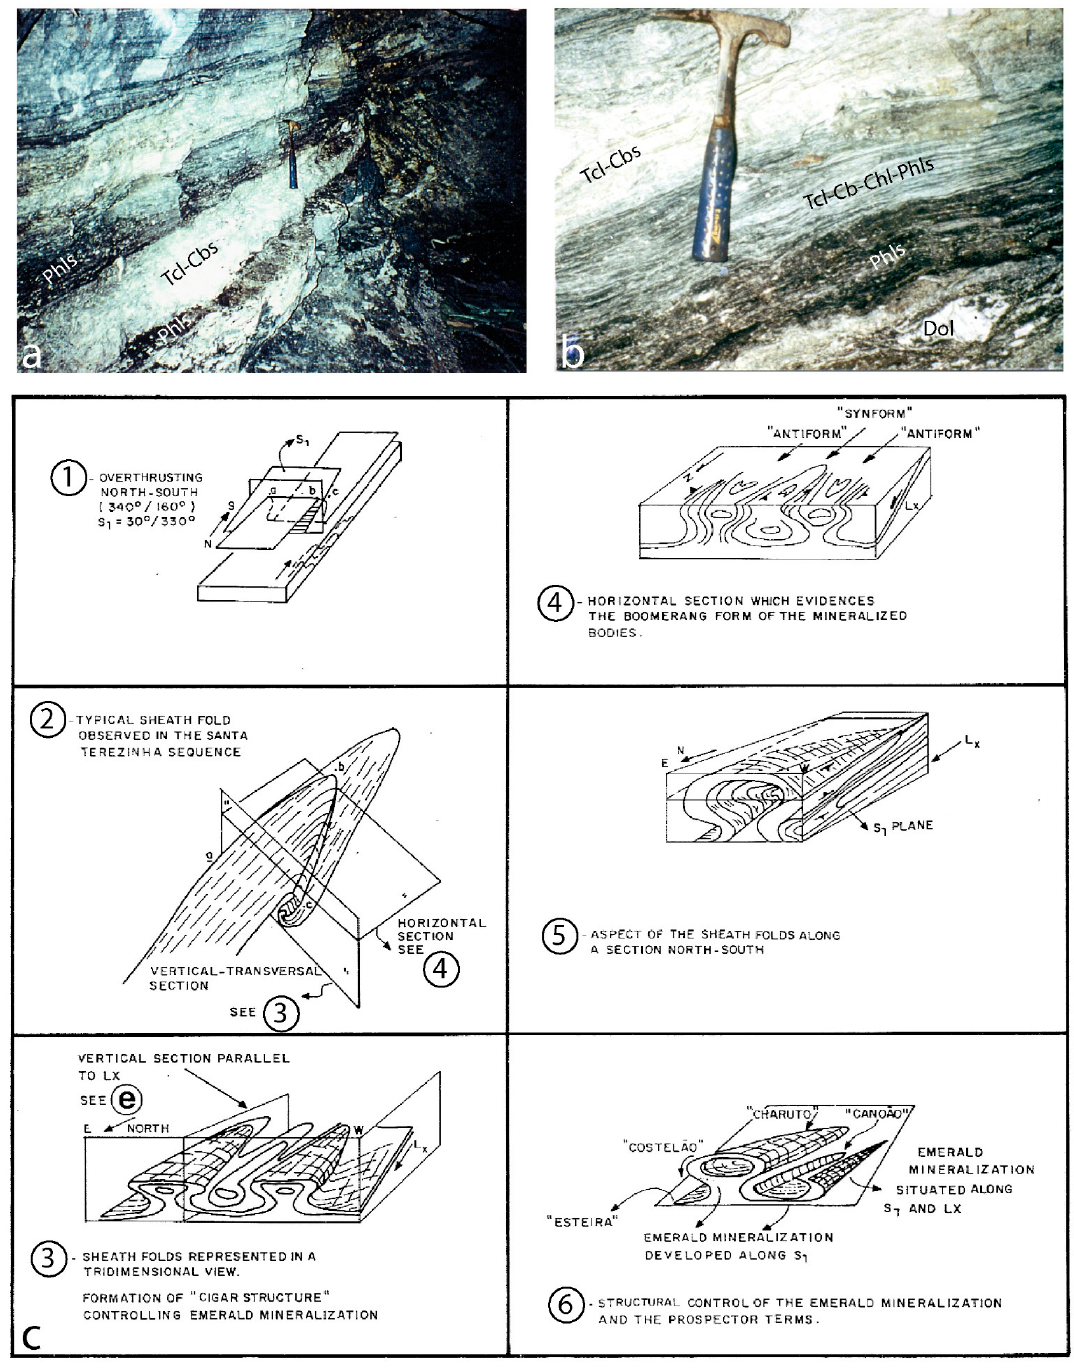
Figure 21. The Santa Terezinha de Goi á s (Campos Verdes) emerald deposit, Goi á s, Brazil: ( a ) Carbonated and phlogopite-rich emerald ores. The phlogopite schists (phls) underline the foliation of the talc-carbonate schists (Tcl-Cbs); ( b ) carbonates lenses (Dol) are observed within the talc-carbonate schists (Tcl-Cbs). The phlogopitisation affects the carbonated-talc-schists and the talc-carbonate-chlorite schist (Tcl-Cb-Chls) showing the “bed-by-bed” fluid injection along foliation planes; ( c ) structural evolution of the Santa Terezinha volcano-sedimentary sequence and the controls of the emerald mineralization on the basis of the structural study done on the Trecho Novo 167 underground mine (EMSA company property). Photographs: Gaston